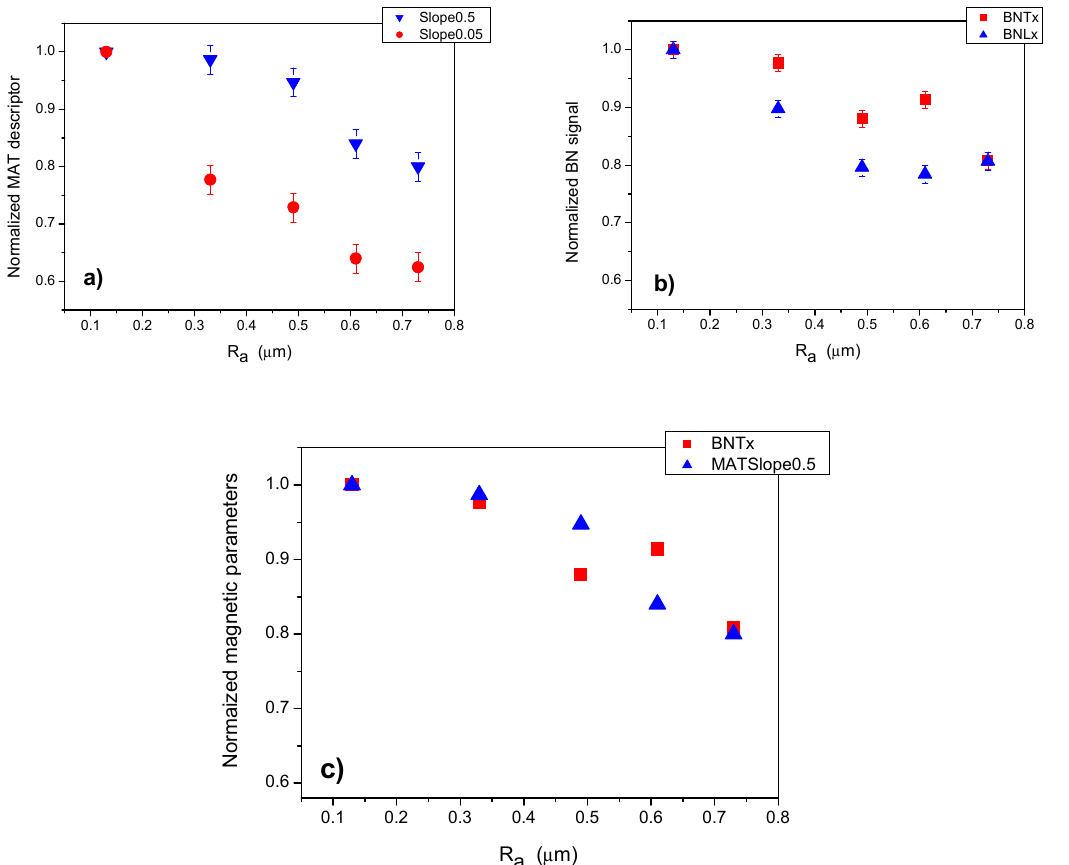
Figure 6. The normalized MAT descriptor with two di ff erent slopes of magnetizing current ( a ), BN signal response in transversal (Tx) and in longitudinal (Lx) orientation ( b ) and comparison of transversal BN signal and MAT descriptor wit 0.5 A / s slew rate of magnetizing current ( c ) as functions of the correlation with R a surface roughness parameter.